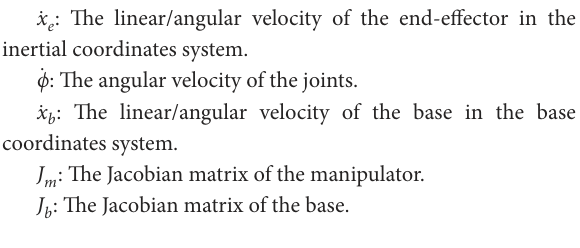
̇ x : The linear/angular velocity of the end-effector in the e inertial coordinates